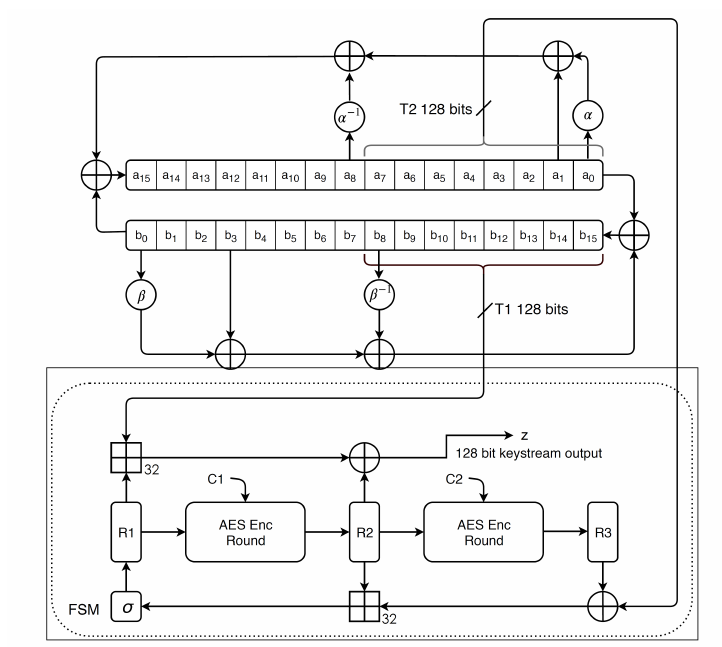
Figure 1: The keystream generation phase of the SNOW-V stream cipher